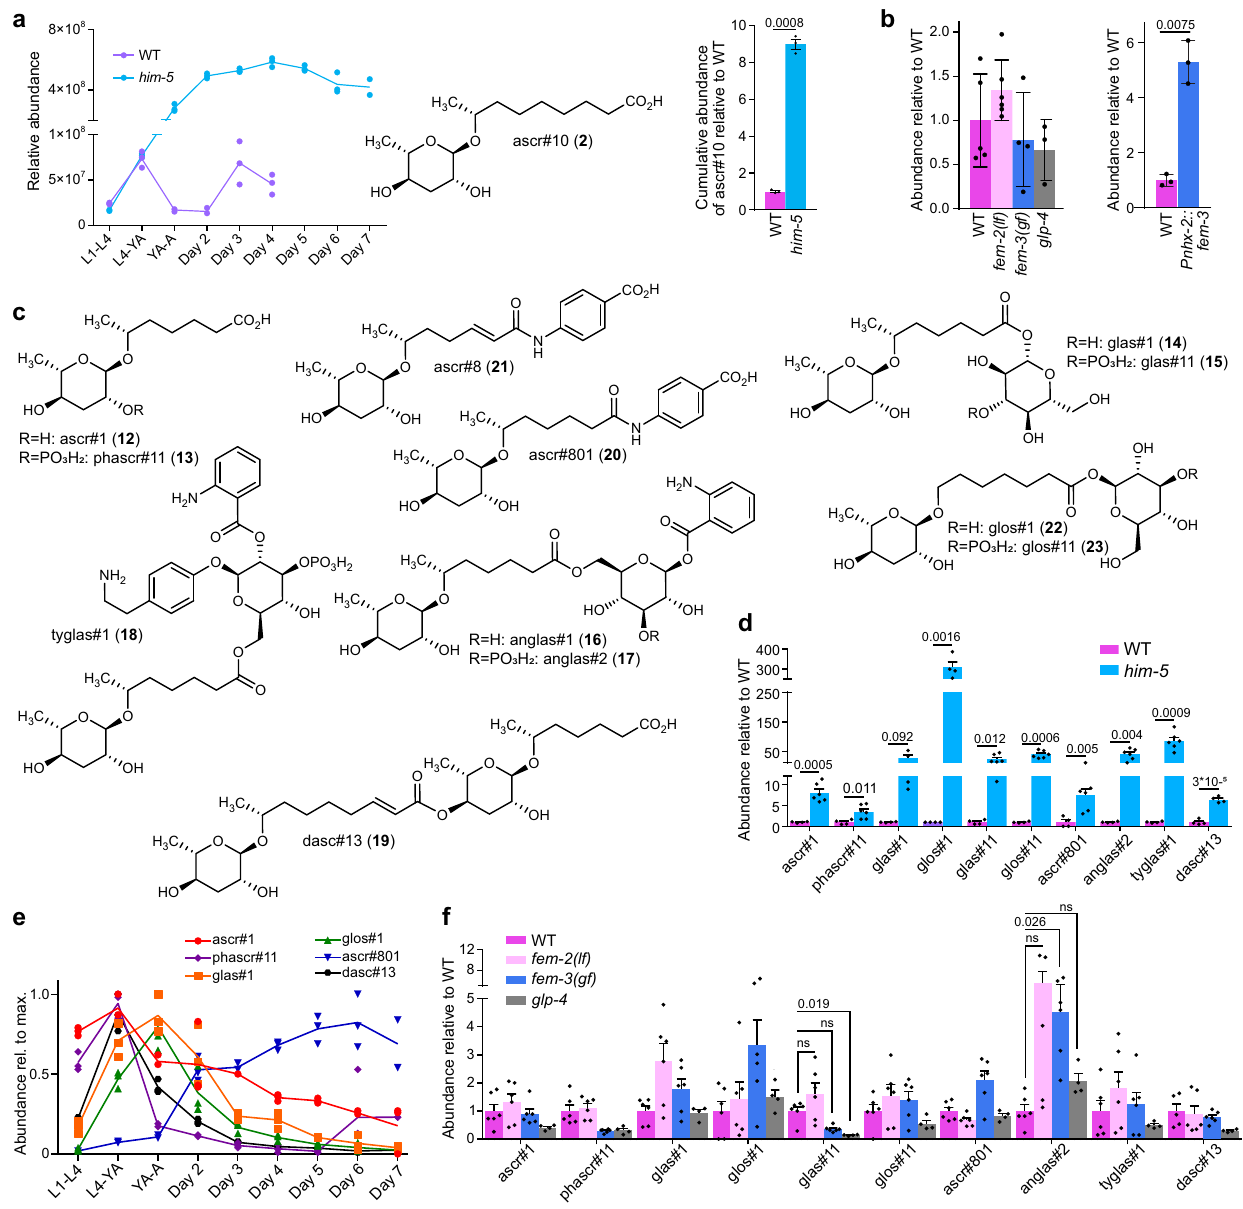
Fig. 3|Enrichmentofascr#10 andascr#1derivativesinmales.a Developmental stage-dependent production of ascr#10 ( 2 ) in WT (purple) and him-5 (light blue) exo -metabolome extracts (left) and cumulative production of ascr#10 by WT and him-5 from the L1 larval stage through day 4 of adulthood (right). Data represent two or three biologically independent experiments, and error bars represent mean±s.e.m. P values werecalculated viatwo-sidedWelch t tests. b Abundance of ascr#10 in germline mutants (left) and intestinally masculinized Pnhx-2::fem-3 ani- mals (right) relative to WT. Data represent three to six biologically independent experiments, and error bars represent mean±s.e.m. P values were calculated via two-sided Welch t tests. c , d Chemicalstructures( c )andrelativeabundances( d )of male-enriched C 7 -sidechain ascaroside derivatives in extracts of the exo - (ascr#1,